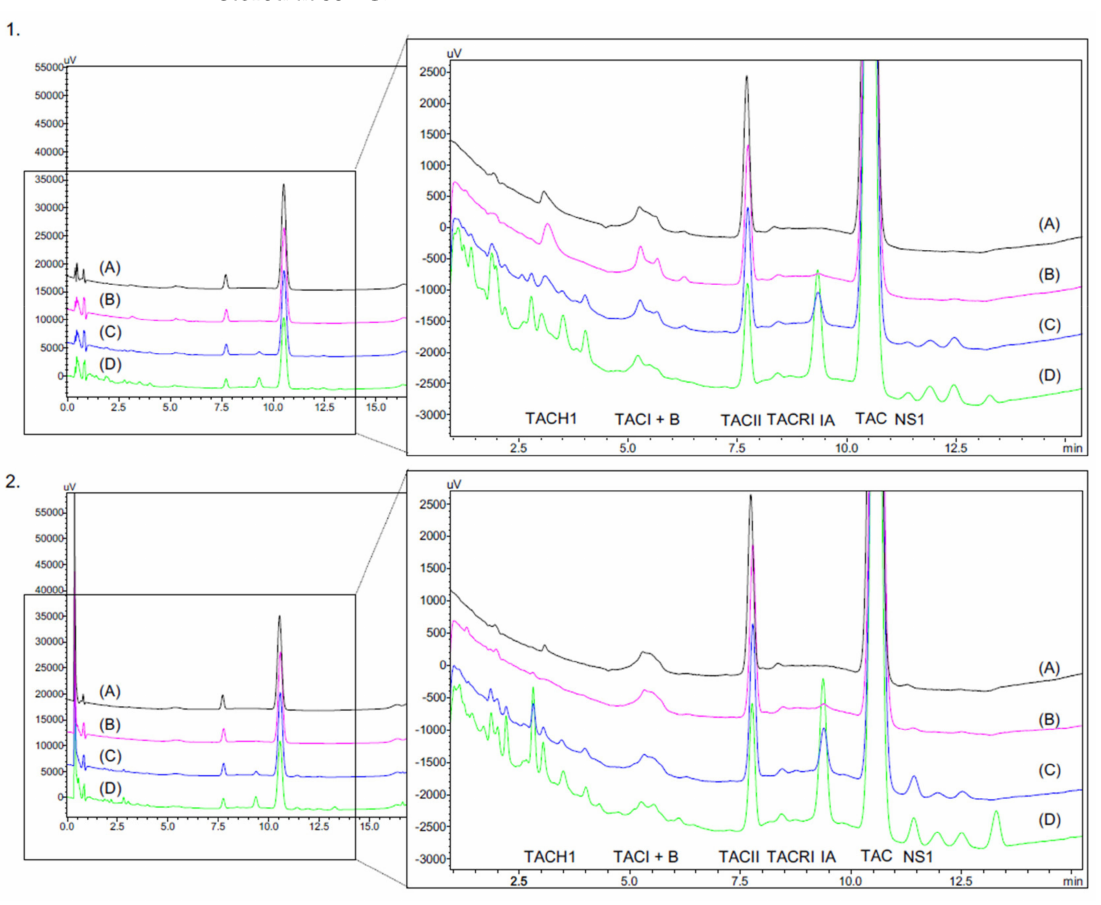
Figure 3. Chromatogram of 1mg/mL ( 1 ) and 0.2 mg/mL ( 2 ) tacrolimus formulations at day 0 (D0) (A) and after six months of storage at various temperature: (B) at 5 ◦ C/M6; (C) at 25 ◦ C/M6; (D) at 25 ◦ C/M6. TAC-H1: tacrolimus alpha-hydroxy acid; TAC I: tacrolimus compound I (diol); B: impurity B; TAC II: Tacrolimus compound II (10-epimer) TAC: Tacrolimus; TAC-RI: tacrolimus regioisomer; IA: impurity A (ascomycin); NS: nonspecified